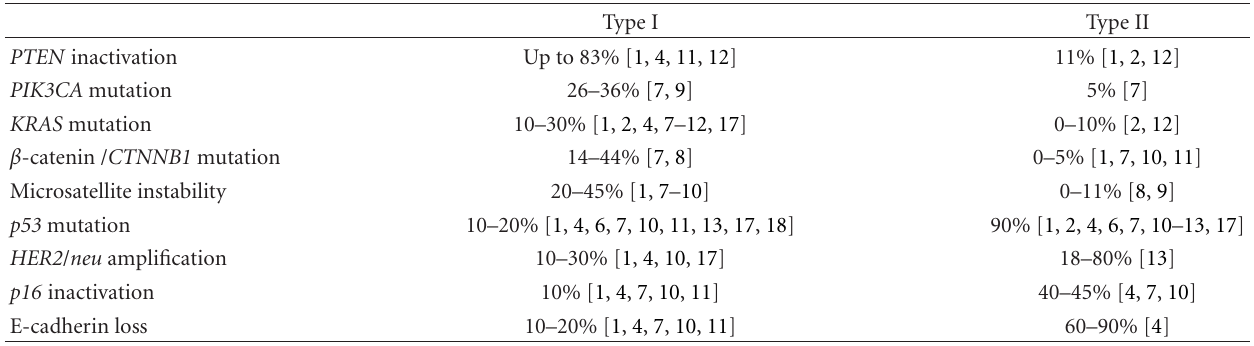
Table 2: Genetic alterations of type I and type II endometrial carcinomas, reported in percentages